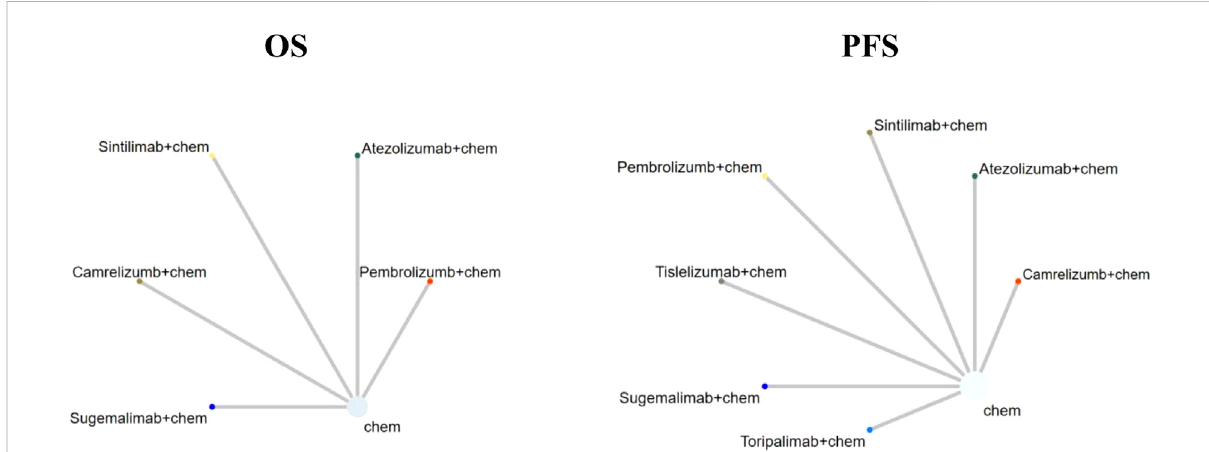
FIGURE 2 Network plot (Comparisons on overall survival (OS) and progression-free survival (PFS). Each circular node represented a type of treatment. Each line represented a type of head-to-head comparison. The size of the nodes and thickness of lines were weighted according to the number of studies evaluating each treatment and direct comparison, respectively; chem: chemotherapy).